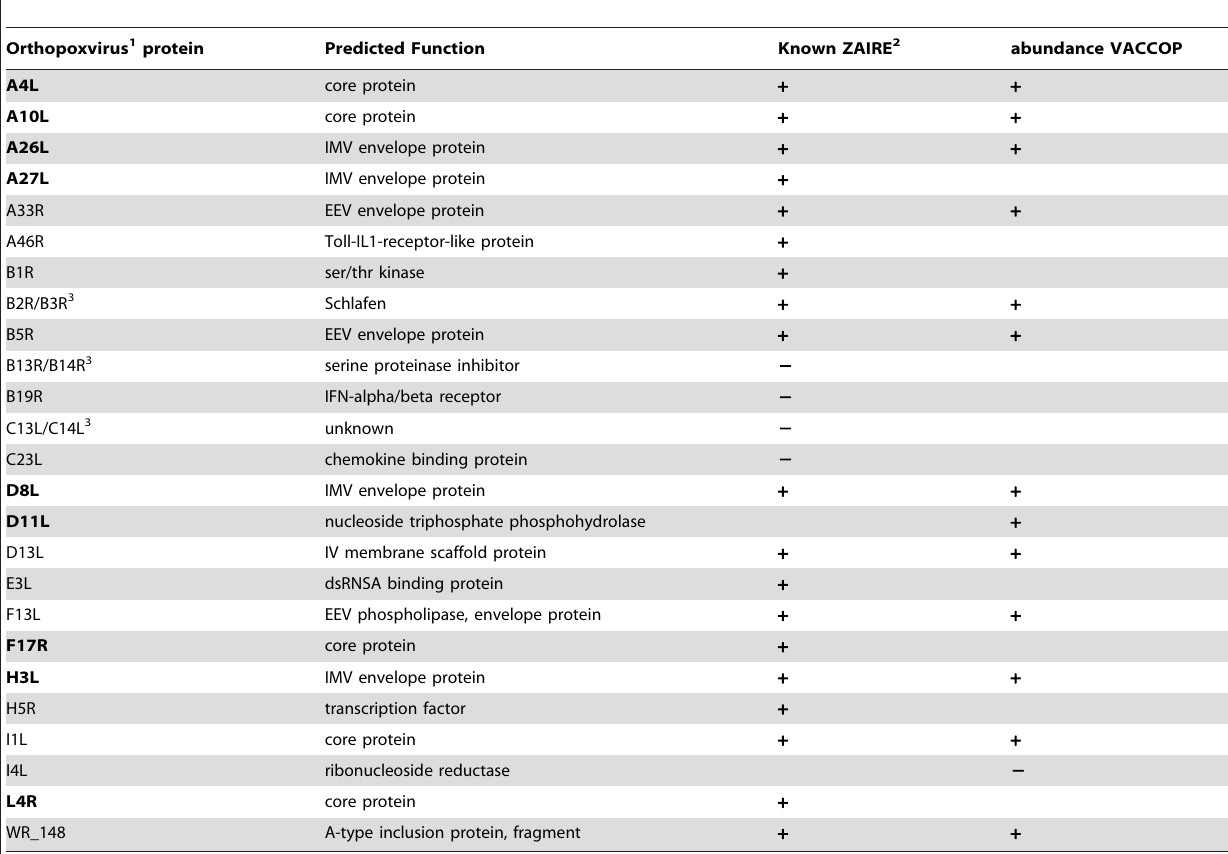
Table 5. Antibody (IgG) responses of convalescent macaque and vaccinated human compared to relative abundance of viral protein.